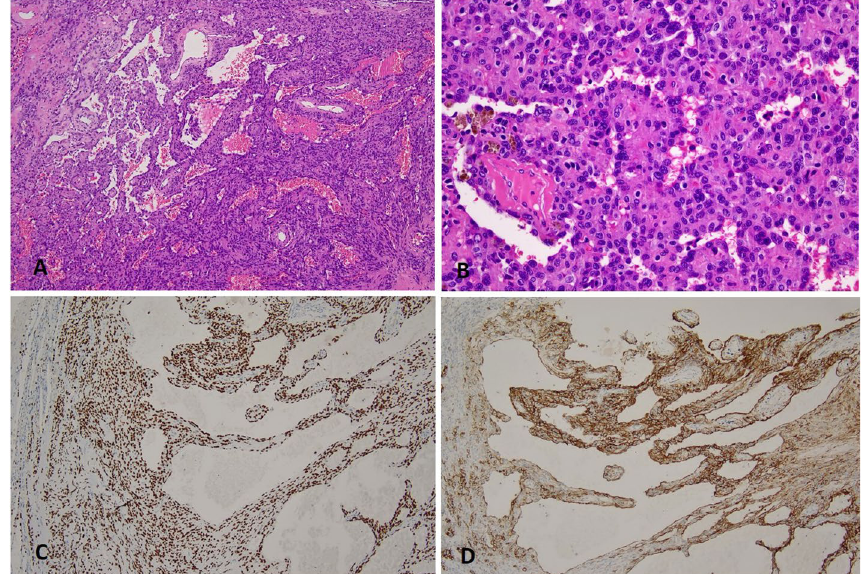
Fig. 1 A , B Typical PSP area of papillary and hemorrhage growth pattern at the periphery of the tumor (H&E stain, immunohistochemical staining of TTF-1 ( C ) and EMA ( D ) (